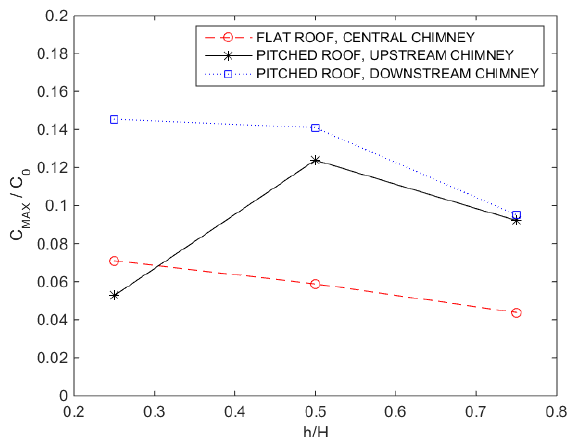
Fig. 18. Maximum mean non- dimensional concentration C MAX /C 0 (C 0 is the mean concentration measured at the end of the chimneystack) inside the first canyon downstream the chimneystack, versus chimneystack height h/H, for the various chimneystack positions on the